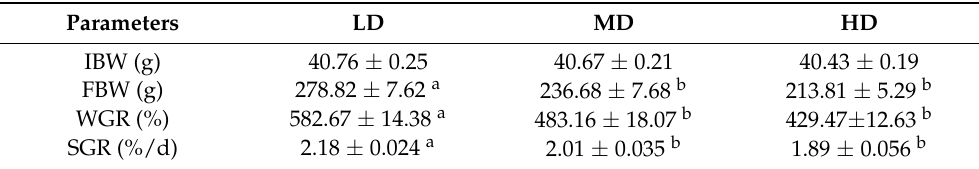
Figure 1. Mean body weight ( A ), mean body length ( B ) and condition factor ( C ) of M. salmoides reared at different densities in an integrated rice–fish farming system. Different letters as superscripts indicate significant differences among the different groups ( p < 0.05). LD, low stocking density; MD, medium stocking density; HD, high stocking density. Table 1. Growth parameters of M. salmoides reared at different densities in an integrated rice–fish farming system after 90 days of